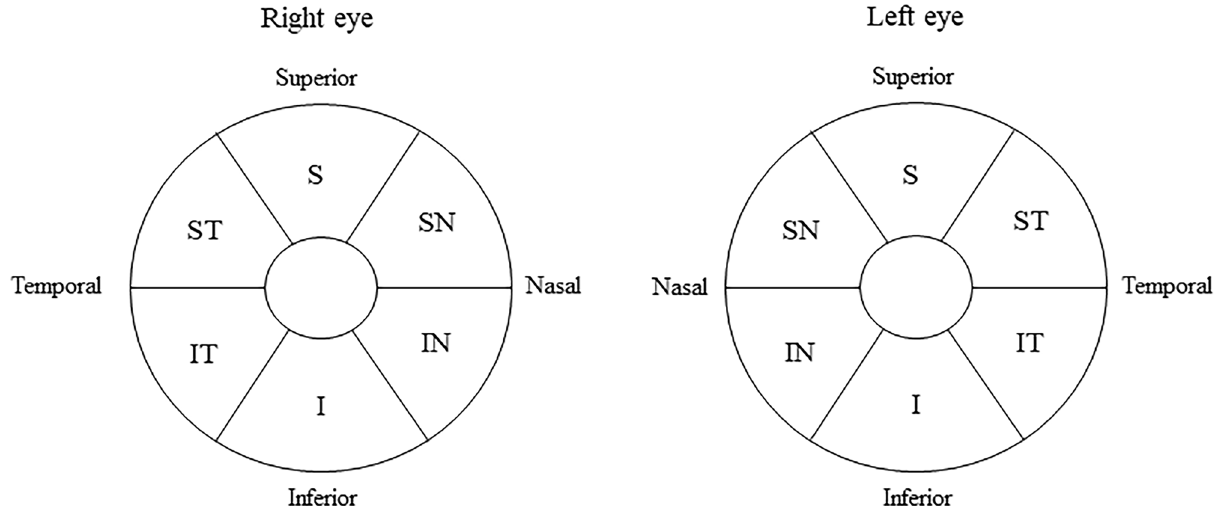
Figure 7. Ganglion cell layer + inner plexiform layer sector map of both eyes using optical coherence tomography. The macular region was divided into six sectors: superior (S), superior nasal (SN), inferior nasal (IN), inferior (I), inferior temporal (IT), and superior temporal sectors